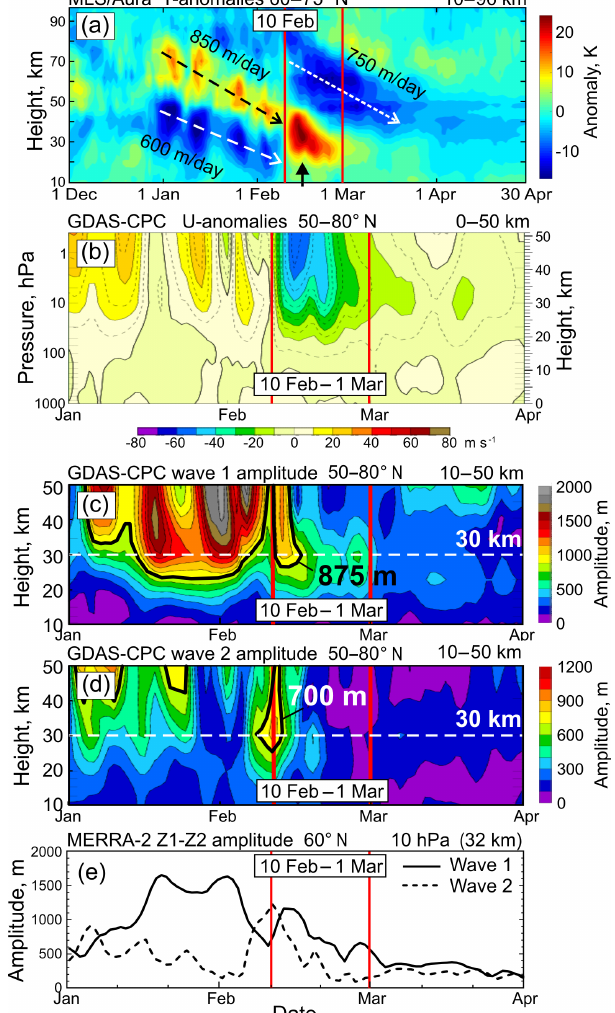
Figure 2. The development of the SSW in 2018 from the verti- cal profiles of (a) Aura MLS temperature anomalies in Decem- ber 2017–April 2018 at polar zone 60–75 ◦ N (with respect to the mean climatology 2005–2017), (b) zonal mean zonal wind anoma- lies, (c) wave 1 and (d) wave 2 amplitudes in geopotential height in January–March by NOAA NCEP GDAS–CPC data (climatology 1981–2010). (e) Zonal wave 1 and wave 2 amplitudes in geopoten- tial height at 10hPa, 60 ◦ N, by the MERRA-2 time series from the NASA GFC ACDL data. The SSW-related anomalous variability between 10 February and 1 March 2018 is bounded by red vertical